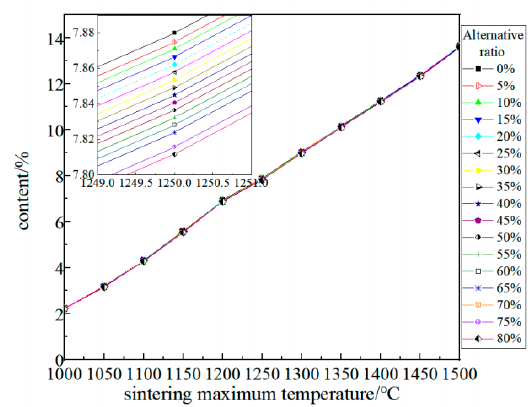
Figure 3. Change of FeO content in the case of straw charcoal substitution.